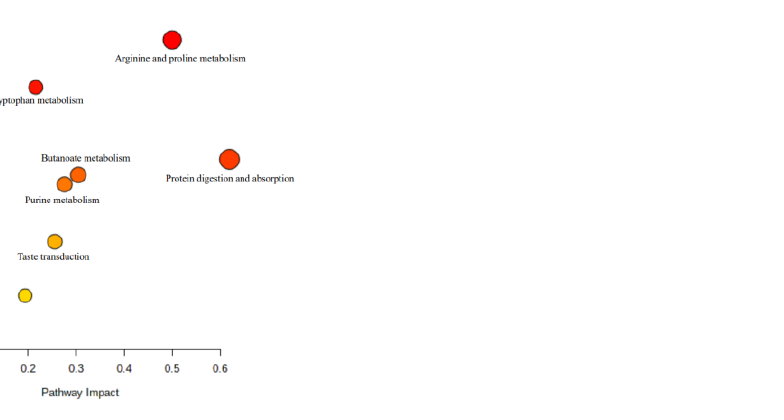
Figure 2. Metabolome view map of plasma metabolites from yaks ( n = 8) fed a high-protein diet versus a low-protein diet. X-axis represents the pathway impact and Y-axis represents the p value. A larger size of the circle indicates more metabolites enriched in that pathway and a larger abscissa indicates higher pathway impact values. A darker color indicates smaller p values. Table 9. Metabolic pathways and significant different metabolites that were enriched in the path- ways of growing yaks fed a low- and high-protein diet.